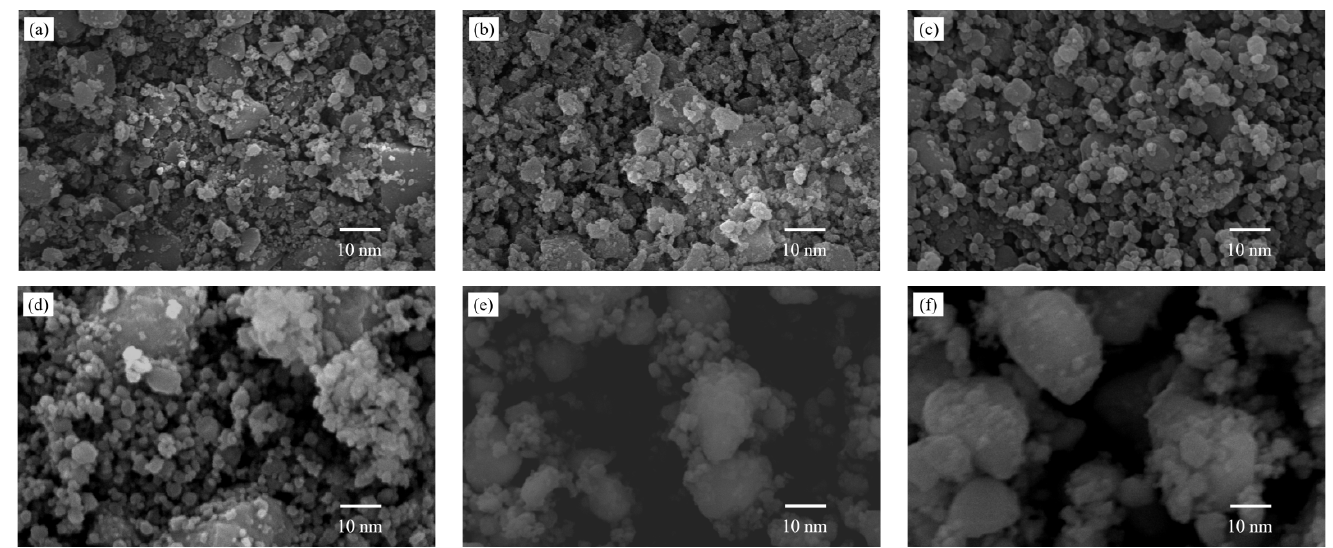
Figure 9. SEM image of Nb/SiO 2 materials with various n Nb calcinations at various temperatures: ( a ) n Nb = 0, 400 °C; ( b ) n Nb = 0.08, 400 °C; ( c ) n Nb = 0.2, 400 °C; ( d ) n Nb = 1, 400 °C; ( e ) n Nb = 1, 600 °C; ( f ) n Nb = 1, 800 °C.